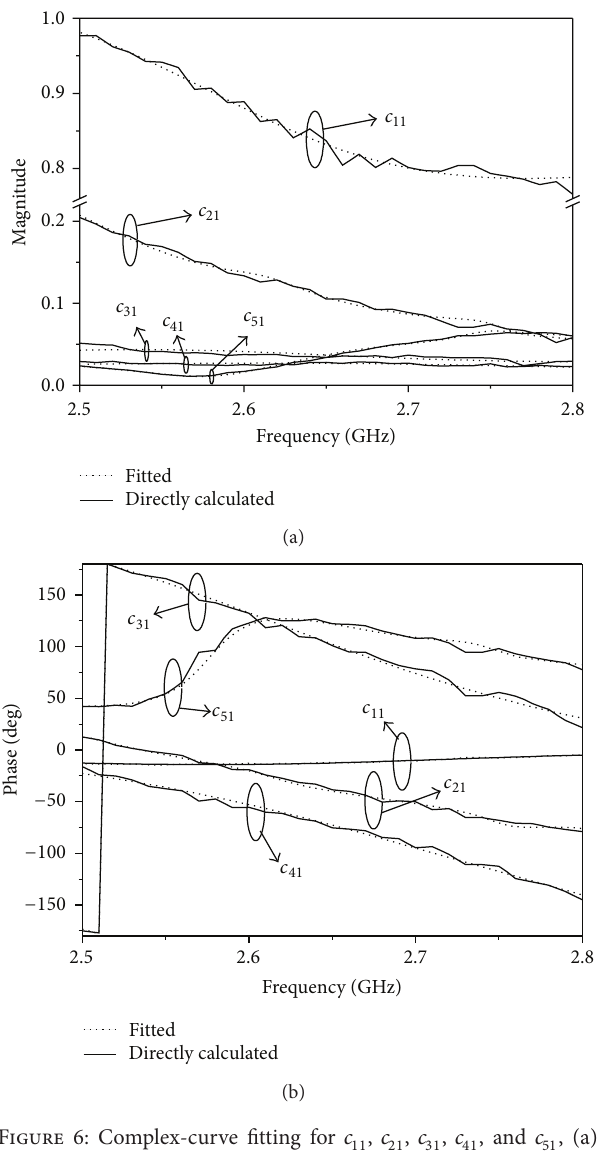
Figure 6: Complex-curve fitting for 𝑐 11 , 𝑐 21 , 𝑐 31 , 𝑐 41 , and 𝑐 51 , (a) magnitude and (b) phase.